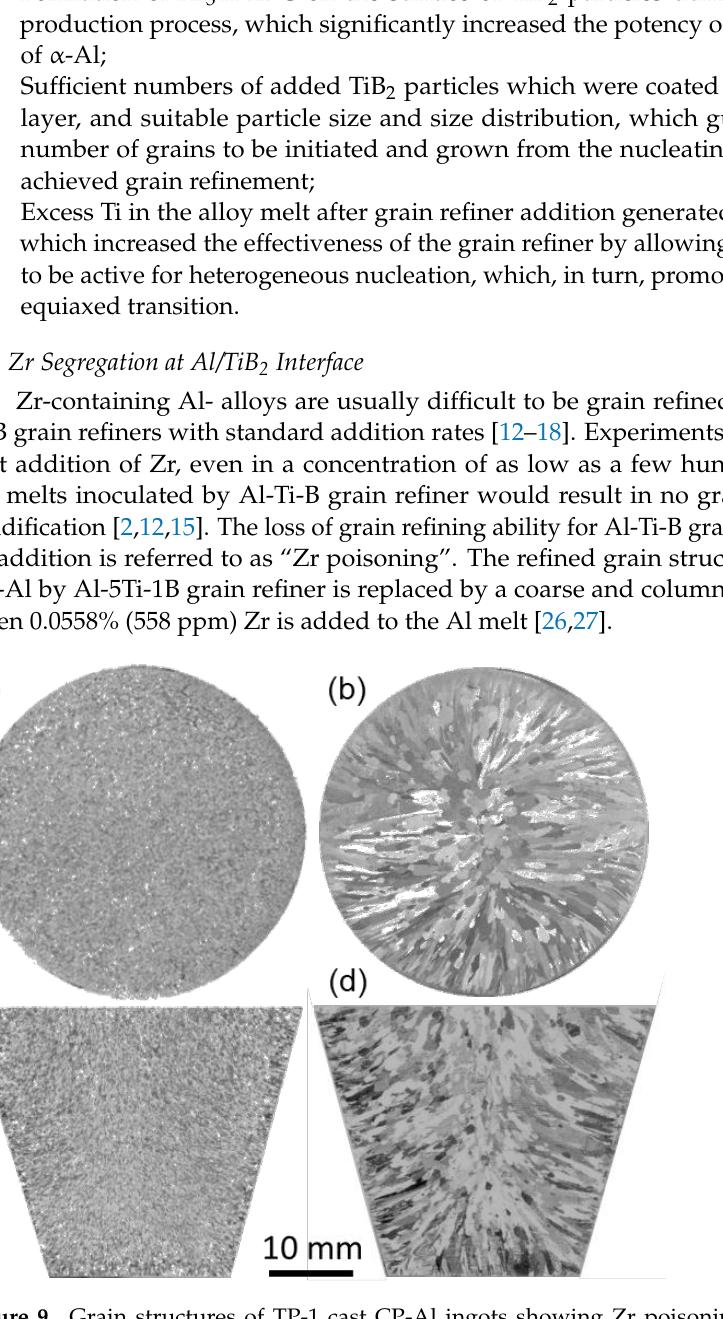
Figure 9. Grain structures of TP-1 cast CP-Al ingots showing Zr poisoning on Al-5Ti-1B grain refiner [26,27]. ( a , c ) With addition of 0.2% commercial Al-5Ti-1B grain refiner and ( b , d ) with additions of both 0.2% of the grain refiner and 558 ppm Zr, showing that the grain refiner lost its ability to grain refine CP-Al when the small amount of Zr was present in the melt. ( a , b ) Transverse and ( c , d ) longitudinal sections.